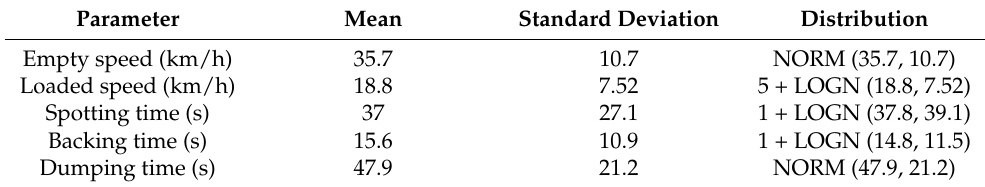
Table A1. Truck input parameters.